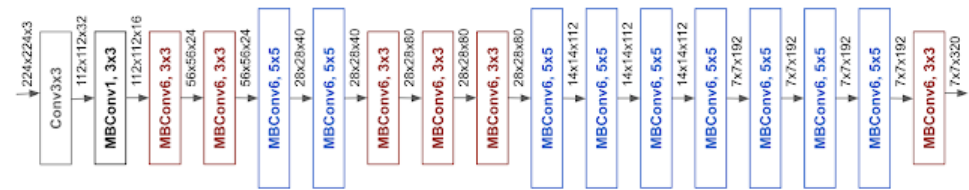
Figure 5. The architecture for baseline network EfficientNet-B0 is simple and clean, making it easier to scale and generalize.